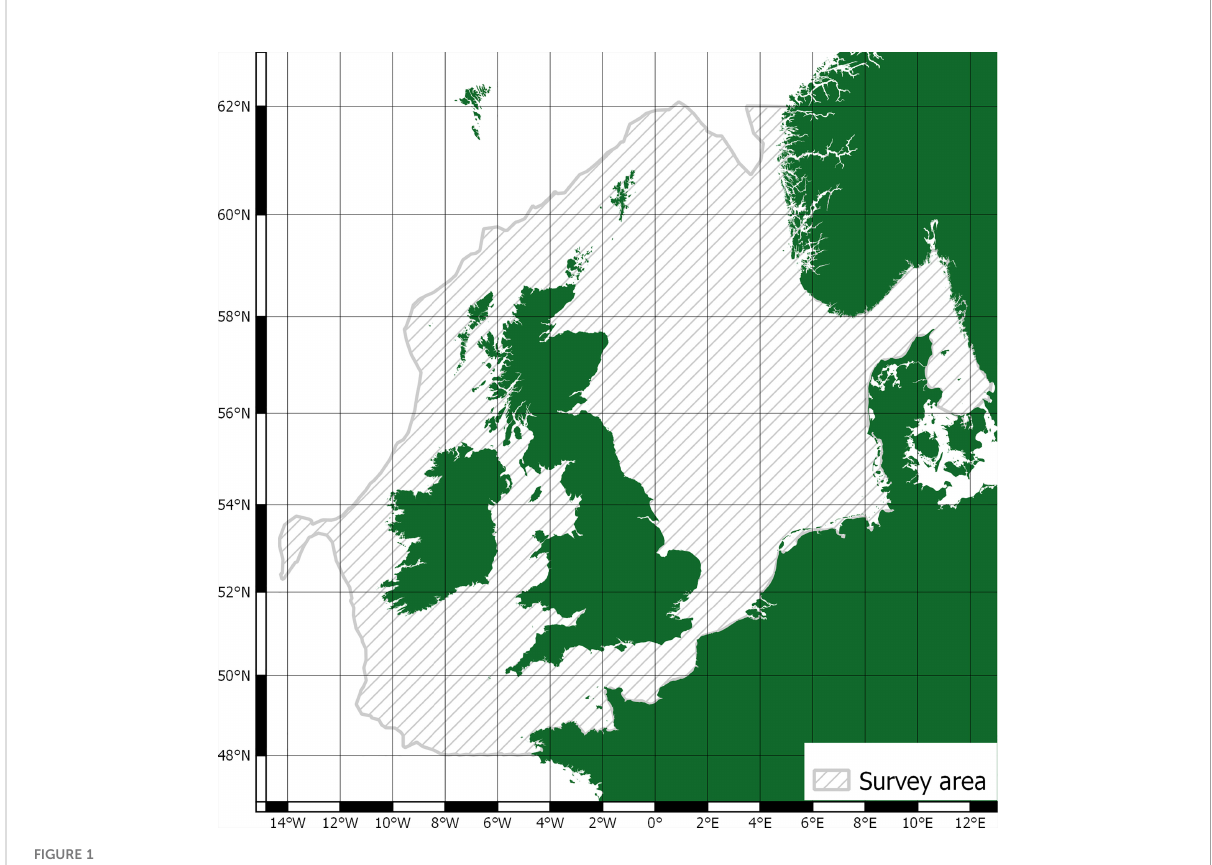
FIGURE 1 Survey